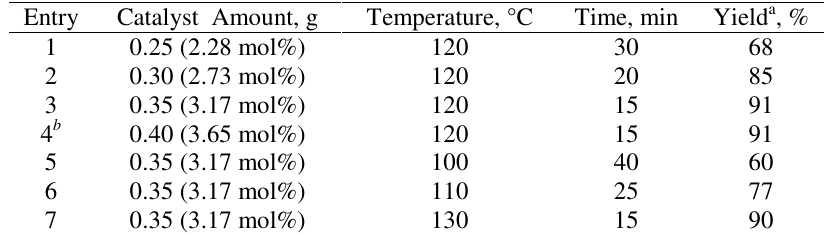
Table 1. The condensation of 2-naphthol (2 mmol), benzaldehyde (2 mmol)